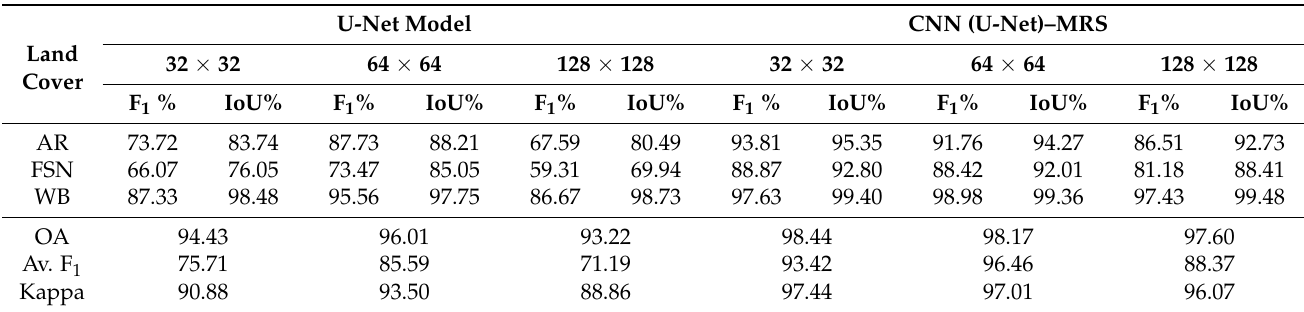
Table 10. Kocaeli test site with 5 bands: performance metrics with U-Net.